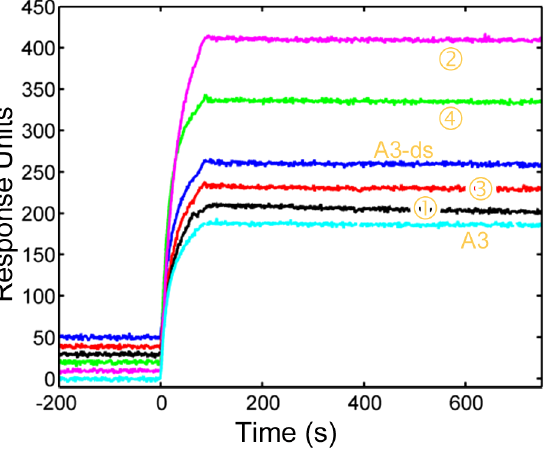
Fig. 4. Binding affinity of mutant constructs. Surface plasmon resonance data is shown for each sdAb. Protein concentration was 300 nM and the data are offset by 10 units each for clarity of the base line. Construct identity is shown by orange labels. Little to no effect on the on-rate or off-rate is